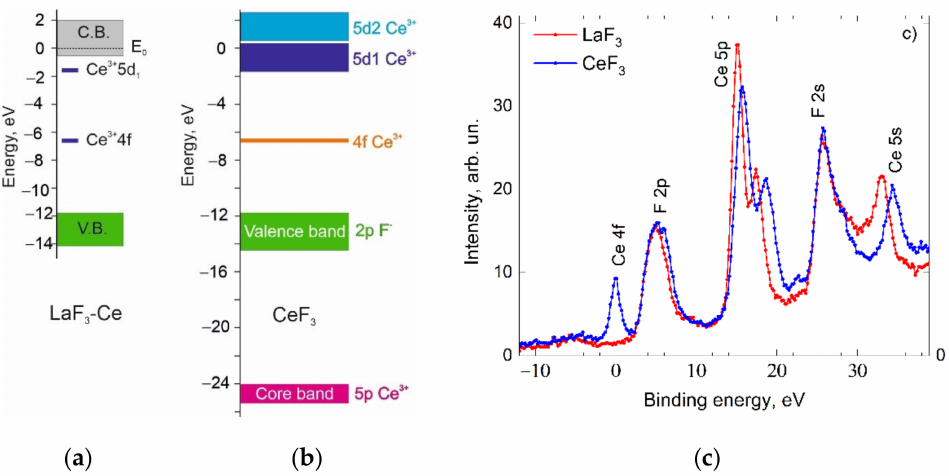
Figure 2. The location of energy levels in the cerium ion of LaF 3 [57] ( a ), the tentative energy scheme for CeF 3 ( b ) and the X-ray photoelectron spectra for LaF 3 and CeF 3 ( c